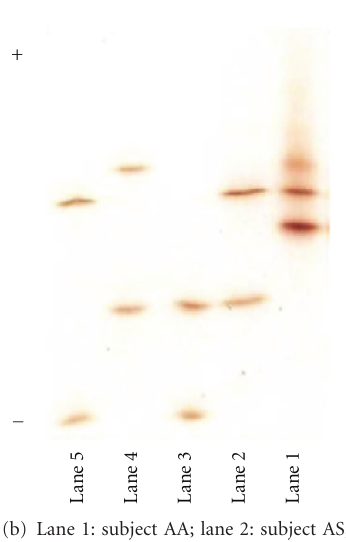
Figure 2: Electrophoresis data of the patient HbS/Hb New york.(a) Electropherogram of the blood sample of the patient with HbS/Hb New York Disease. (b) Isoelectrofocusing data for the same sample.